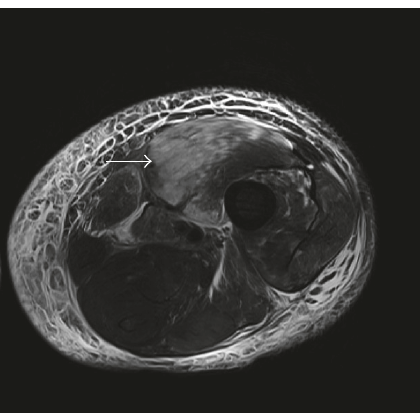
Figure 1: MRI of the left thigh, coronal section, showing hyperin- tense signals on T2 weighted images (white arrow).